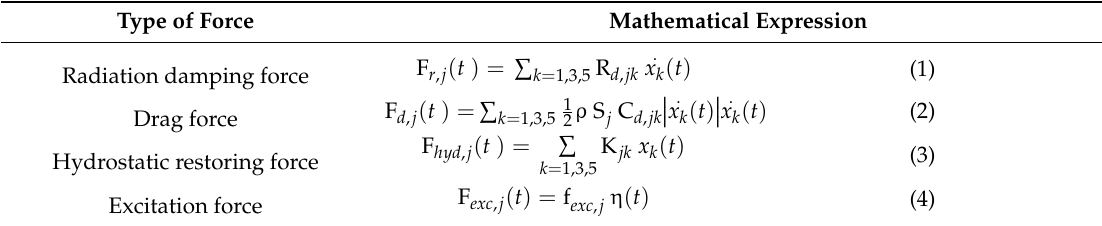
Table 4. Type of acting forces and their mathematical expression reported in the implemented potential